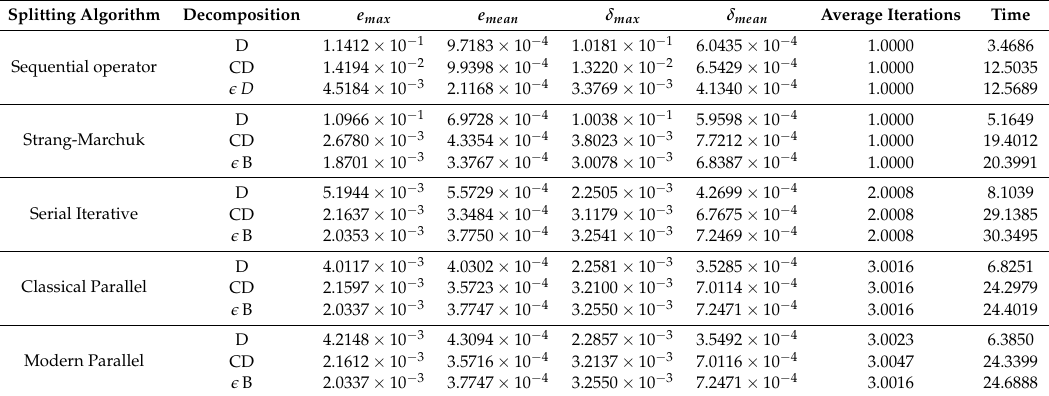
Table 16. Mixed convection-diffusion and Burgers’ equation with 10 spatial intervals and 640 temporal steps. Results of the different splitting methods with directional decomposition, D, convection-diffusion decomposition, CD, and (cid:101) -balanced decomposition, (cid:101)